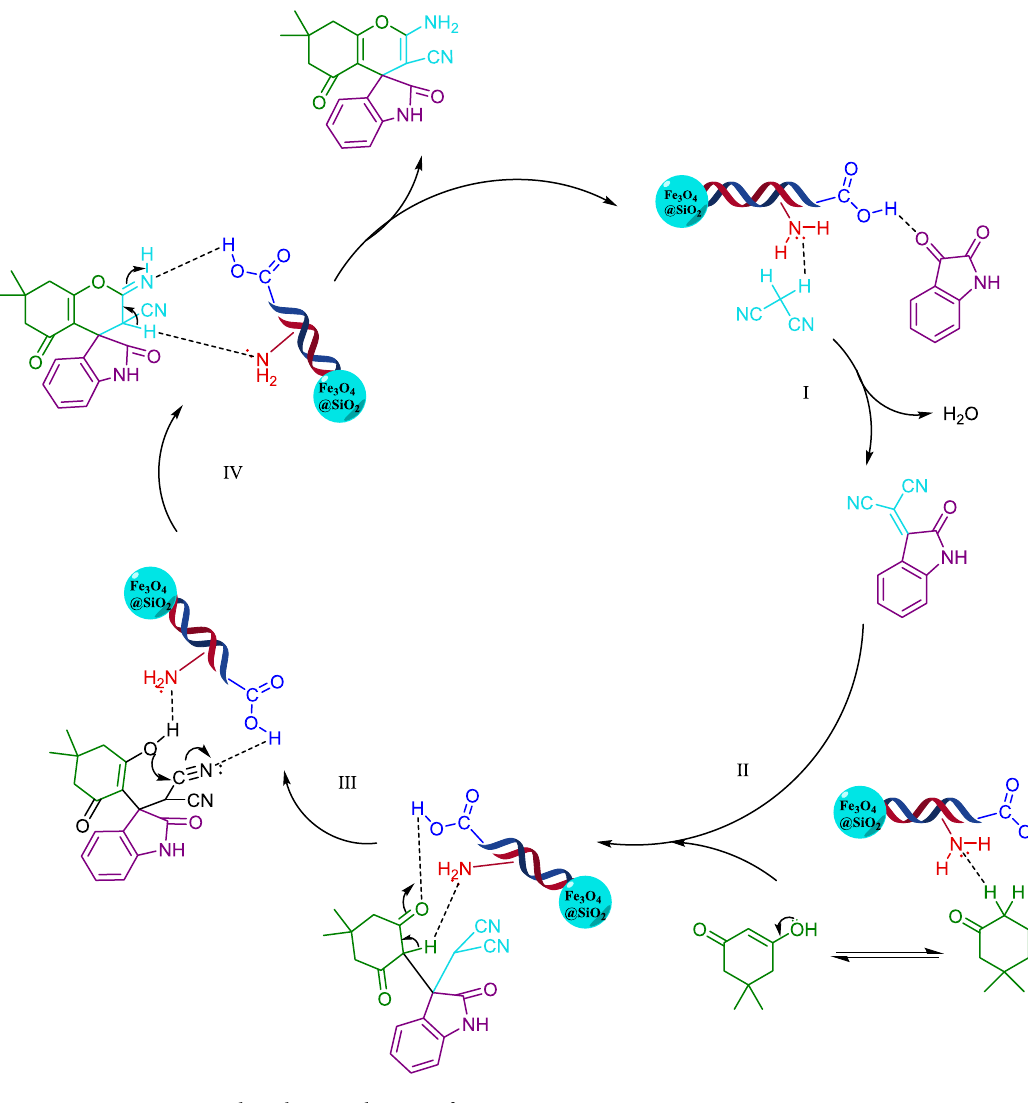
Figure 9. Proposed catalytic mechanism of Fe 3 O 4 @SiO 2 /ECH/IG.